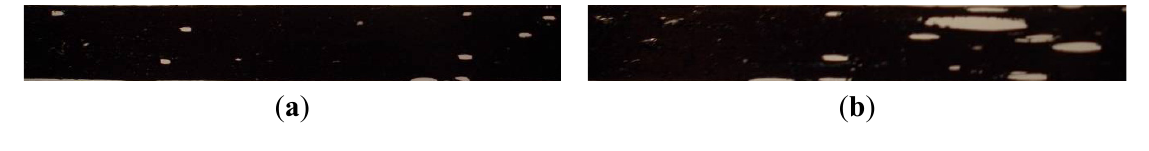
Figure 4. Optical photographs showing the defects during the tensile test of the EOC sample containing 20% of oxidized CNTs. Image rotated by 90 degrees. ( a ) Small deformation; ( b ) Large deformation before